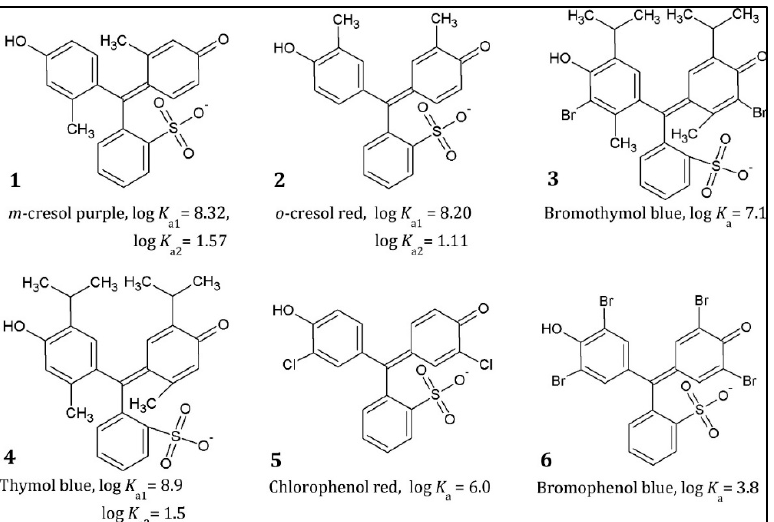
Figure 8. Dyes were used as sensing moieties. Reprinted with permission from the reference [73]. Copyright 2021 American Chemical Society.